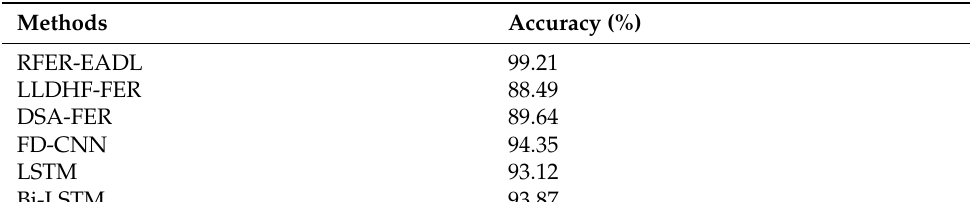
Table 5. Comparative analysis of RFER-EADL and other modern algorithms.